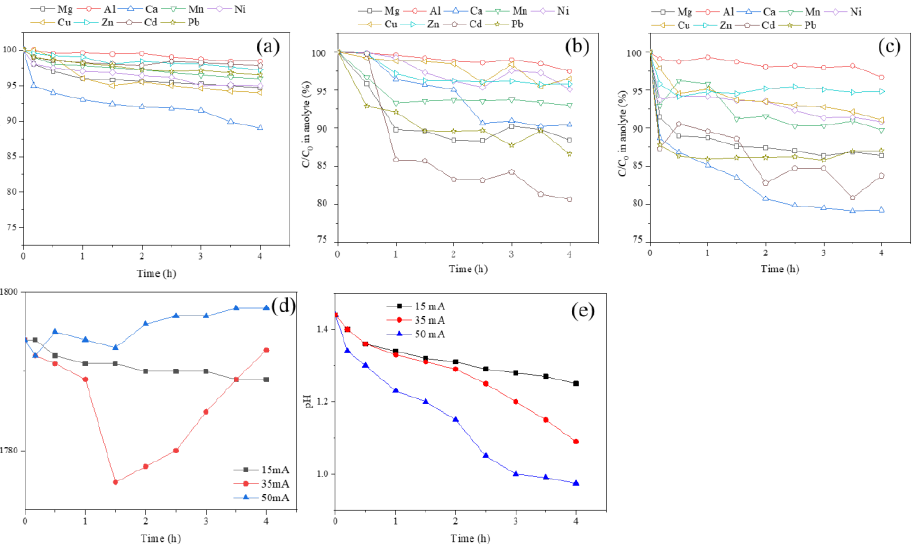
Figure 2. Heavy metals/metals (C/C 0 in percentage) (( a – c ) is 15 mA, 35 mA and 50 mA, respectively), P concentration ( d ) and pH changes ( e ) in anolyte, in first 4